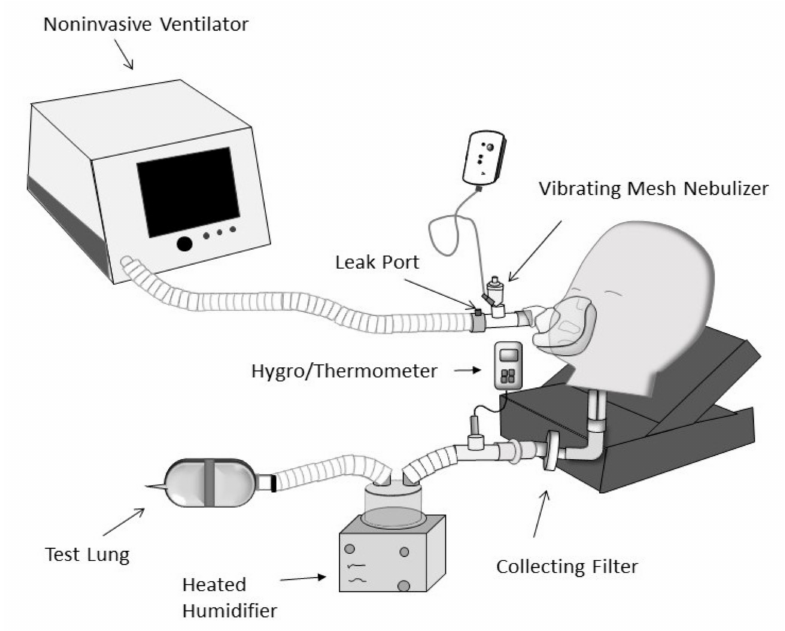
Figure 3. Lung model used to simulate a child receiving noninvasive ventilation Adapted from [21], ERJ Open Research, 2021.